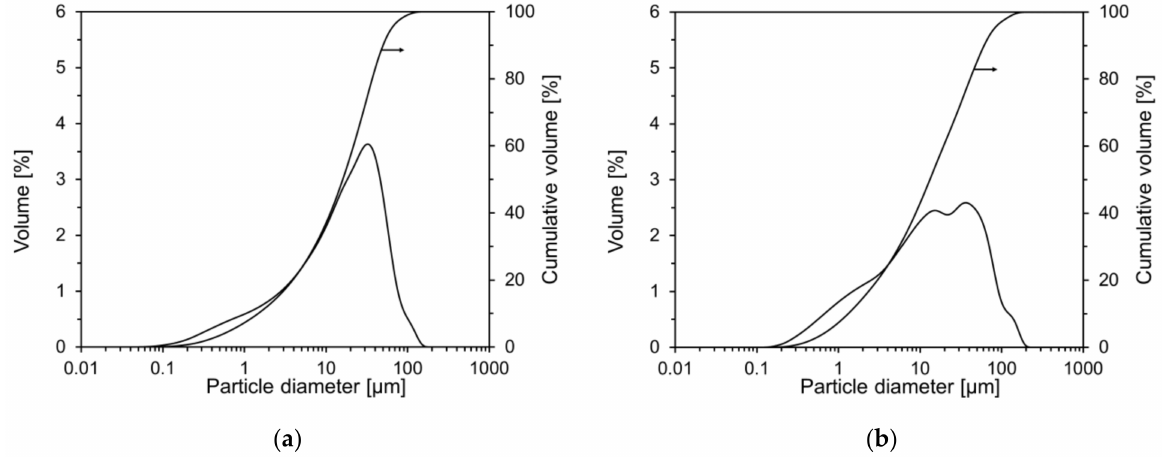
Figure 3. Measured PSDs of raw materials: ( a ) OPC; ( b )